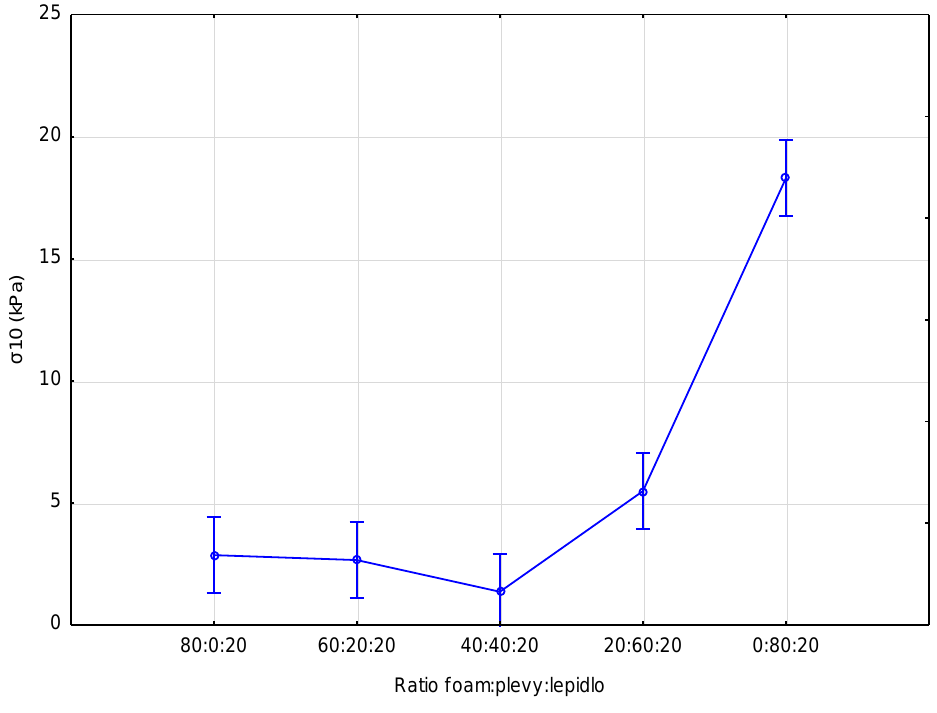
Figure 5. Impact of the composition of the panel on stress at 10% compression. Table 7. p-values of Tukey post-hoc test: statistical significance of the differences in the graph in Figure 5. Ratio